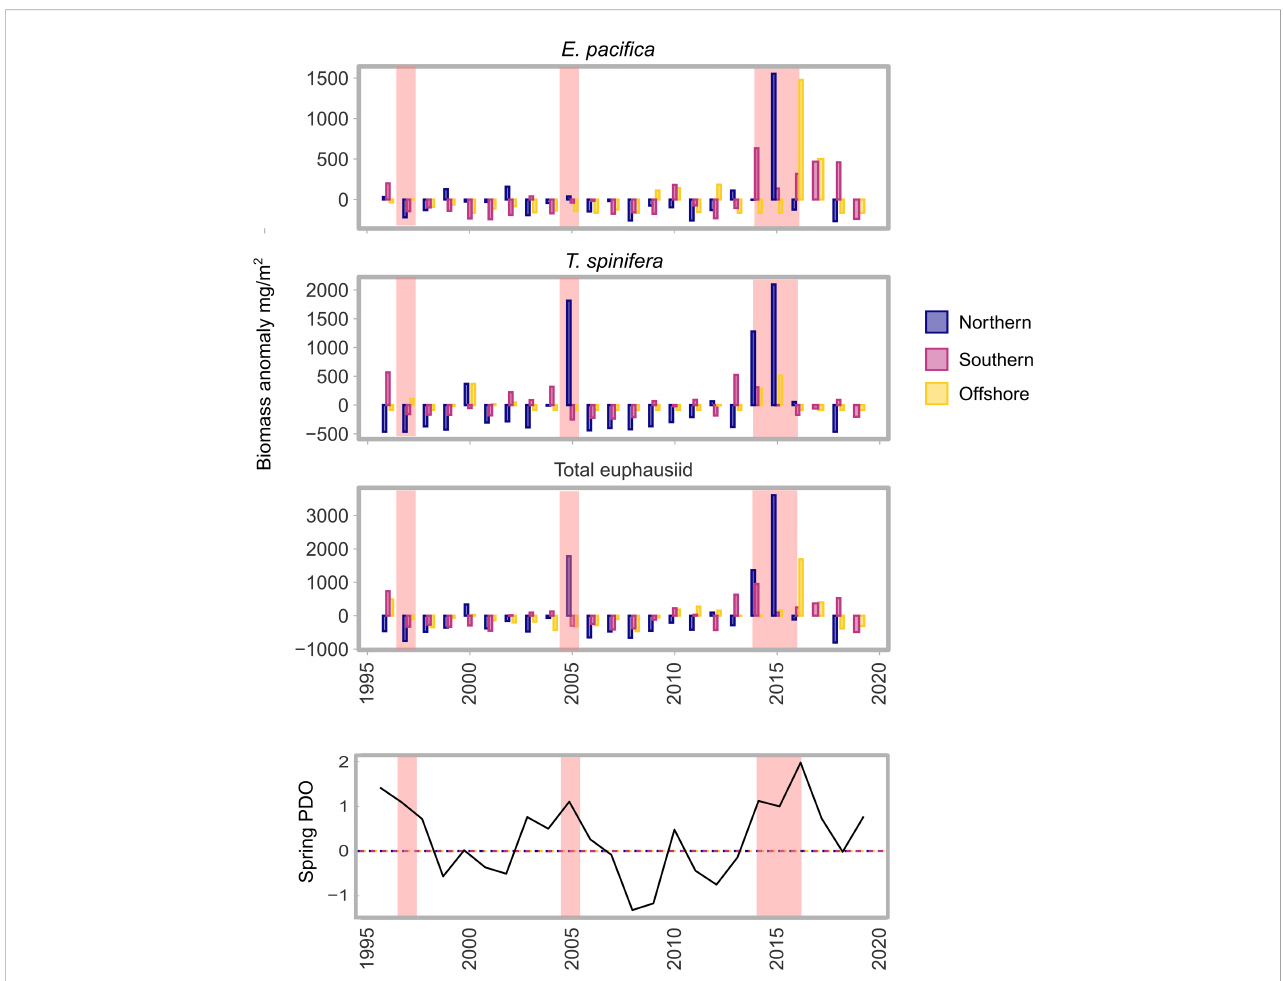
FIGURE 4 Annual mean anomaly (across stations) of sampled euphausiid biomass for each bioregion. Anomalies were calculated based on the time-series analysed: 1996-2019. Spring PDO shows the PDO phase during April, May and June of each year. Red highlighted regions represent ‘ warm ’ periods that are mentioned in the text; the 1997 El Niño, the 2005 ‘ warm ’ event, and the 2014-2016 MHW